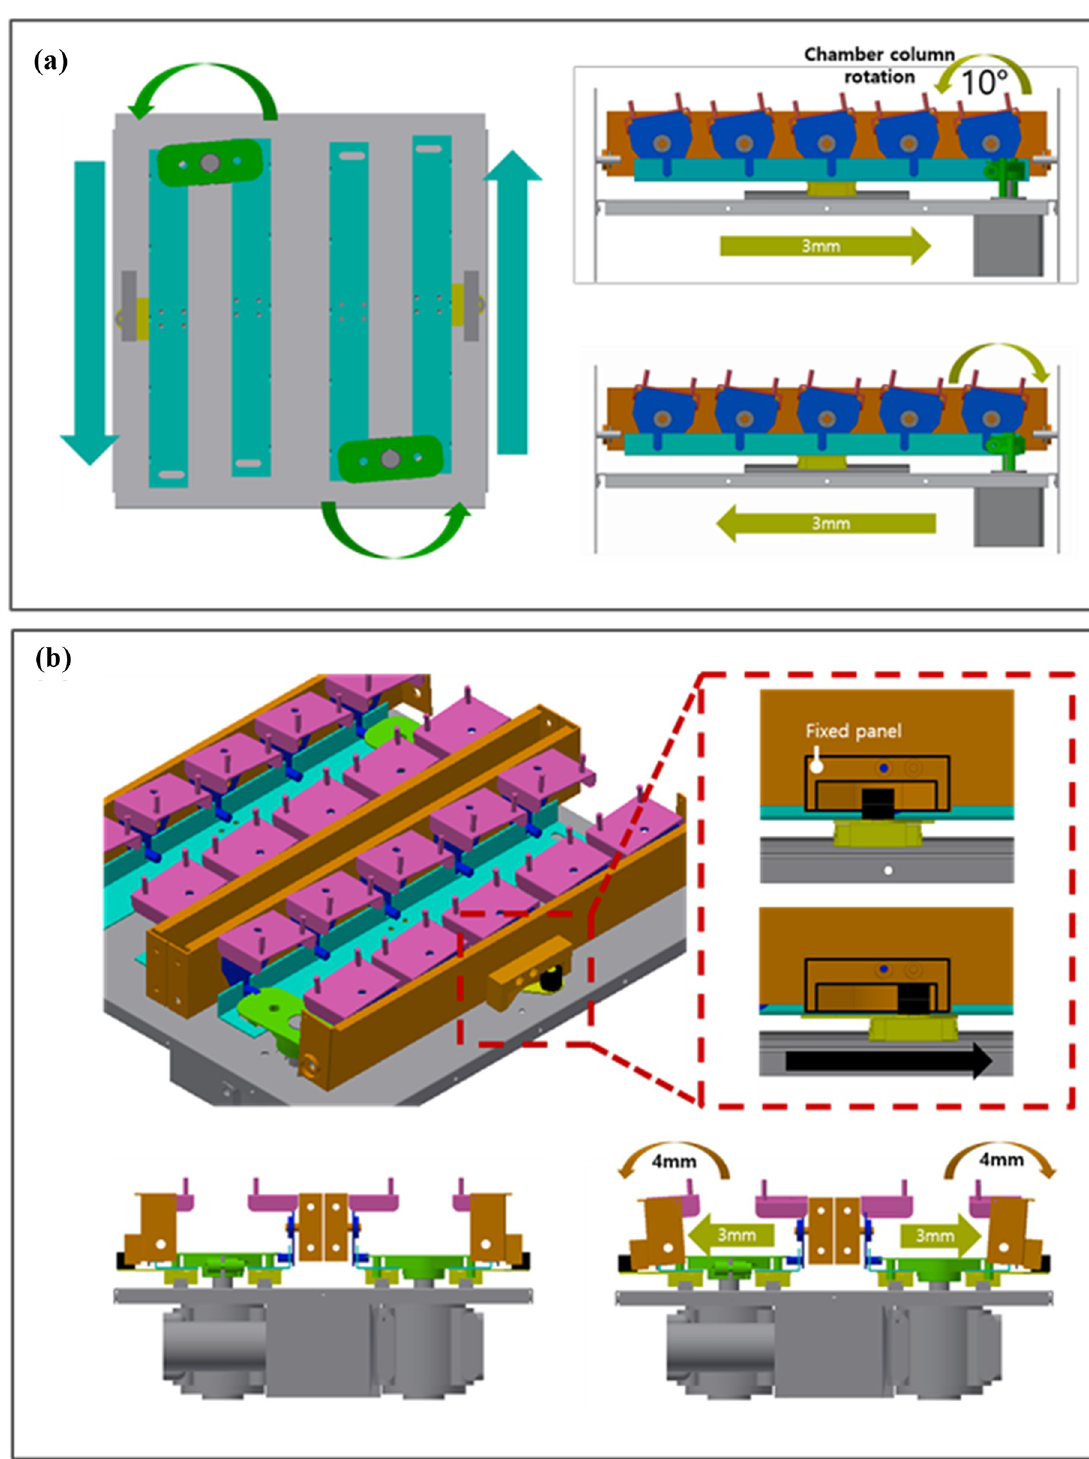
Fig 3. Two-step motor generators. (a) Producing a 10-degree rotational tilt of the chamber corners with resultant torsional stretch on the PDMS chambers (b) 4-degree tilt away from the panel results in 2 mm stretch and 3 mm sliding of each panel beneath the chambers.